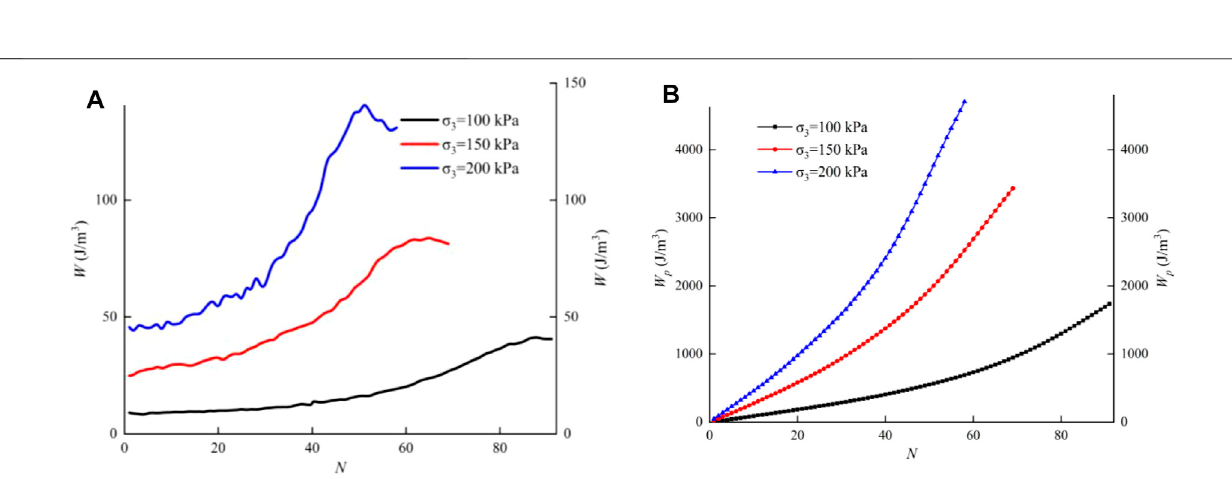
Frontiers in Earth Science |